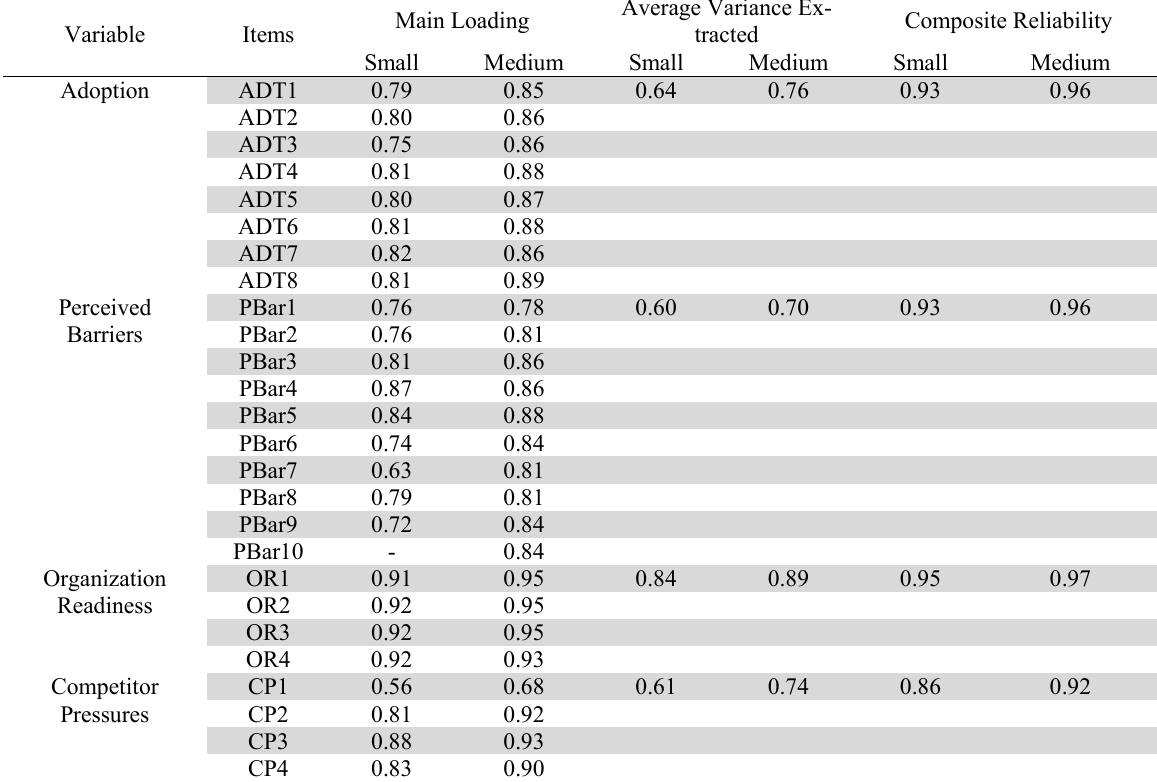
Measurement Model